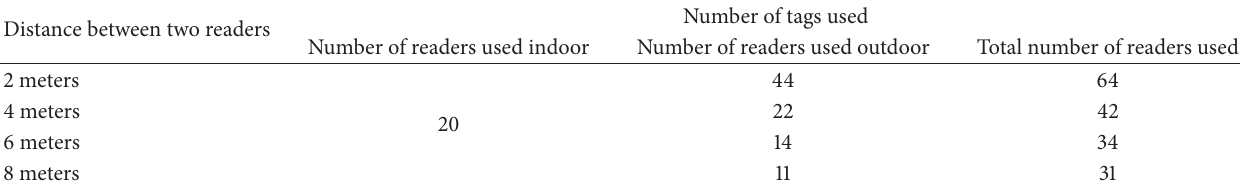
Table 6: Number of tags used under different distance between two readers. Number of tags used Distance between two readers Number of readers used indoor Number of readers used outdoor Total number of readers